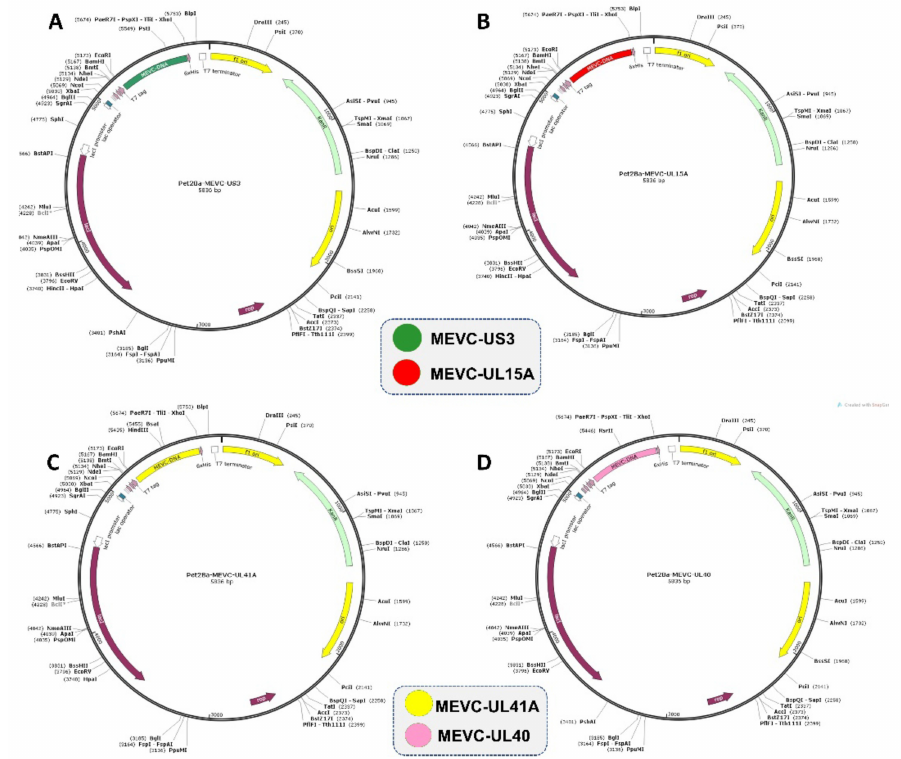
Figure 5. Represents the in silico cloning designs of the final multi-epitope-based vaccine against each specific target protein of HCMV. The different inserts in the same vector (Pet28a+) are represented with specific colors (Green, Red, Yellow and